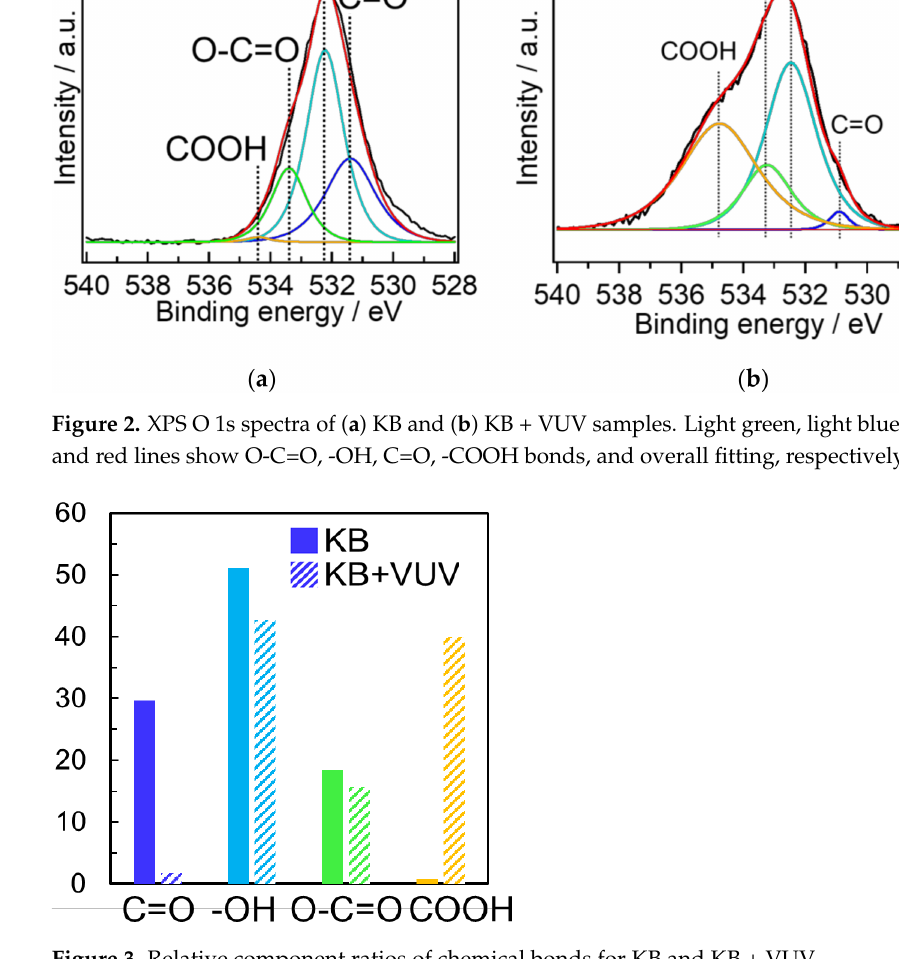
Figure 3. Relative component ratios of chemical bonds for KB and KB + Figure 3 . Relative component ratios of chemical bonds for KB and KB+VUV.